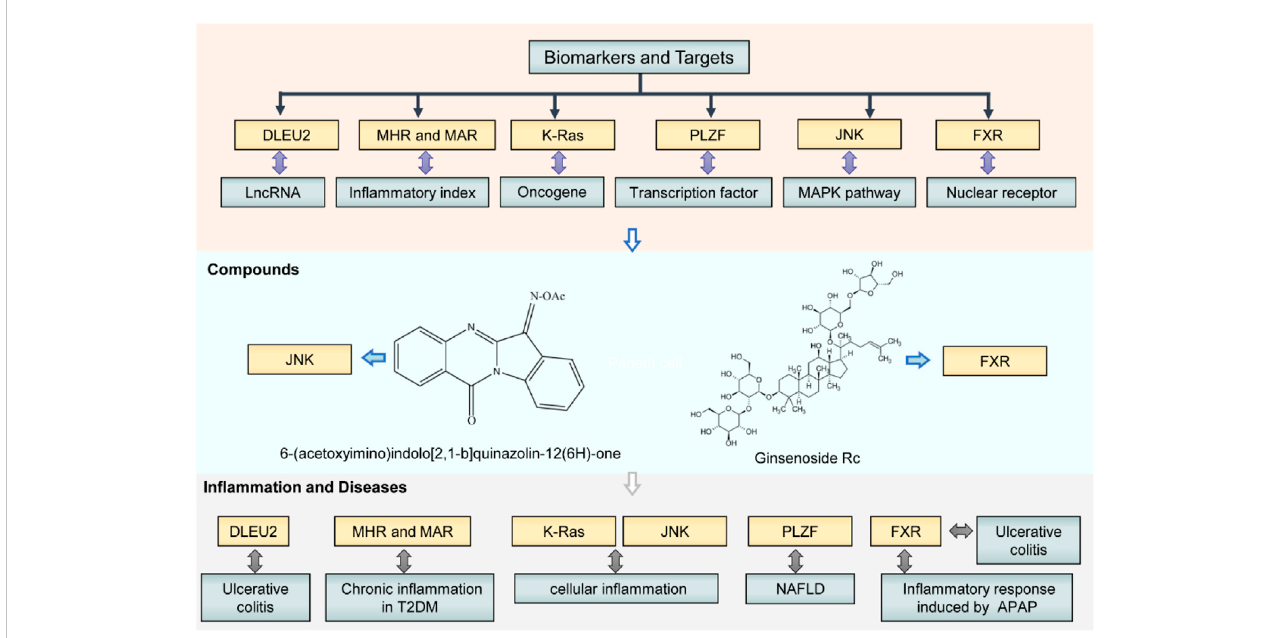
FIGURE 1 Biomarkers, targets, and compounds for the management of in fl ammatory diseases in this Research Topic. These biomarkers and targets consist of lncRNA, oncogene,key proteinof signaling pathways, and transcriptionalfactor(e.g.,nuclear receptor). Therapeutic agents include natural (e.g., Ginsenoside Rc) and synthetic compounds (e.g., O-substituted tryptanthrin oxime derivatives). NAFLD, non-alcoholic fatty liver disease; T2DM, type 2 diabetes mellitus; APAP,